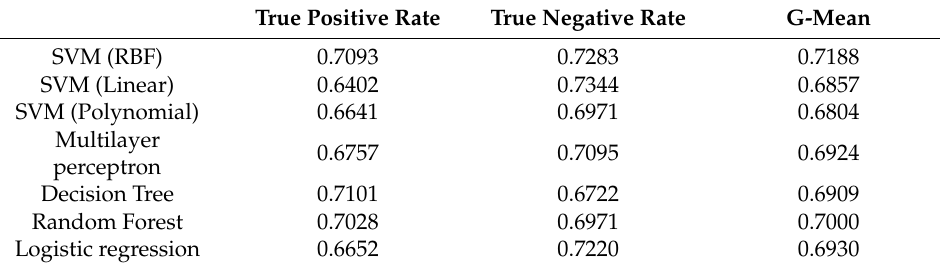
Table 5. Comparison of the performance between the SVM and other classificiation